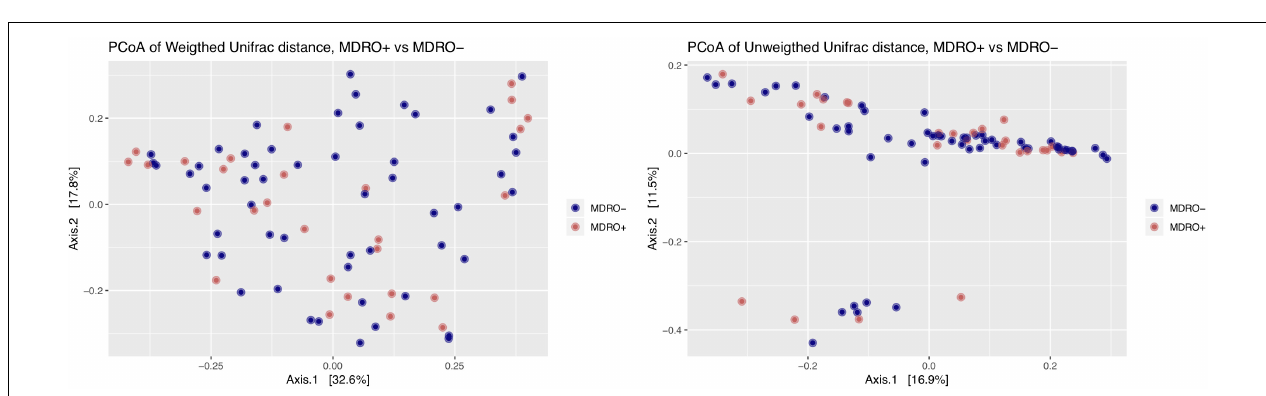
FIGURE 4 | Analysis of alpha diversity based on observed number of ASV (left panel) and the Shannon index (right panel) between a priori fecal samples from study subjects who acquired MDRO (MDRO+) or not (MDRO–). Neither of the distributions were significantly different ( P > 0.1) between the MDRO+ and MDRO- subjects. ASV, amplicon sequence variant; MDRO, multidrug-resistant organisms. Dots represent patient’s samples.